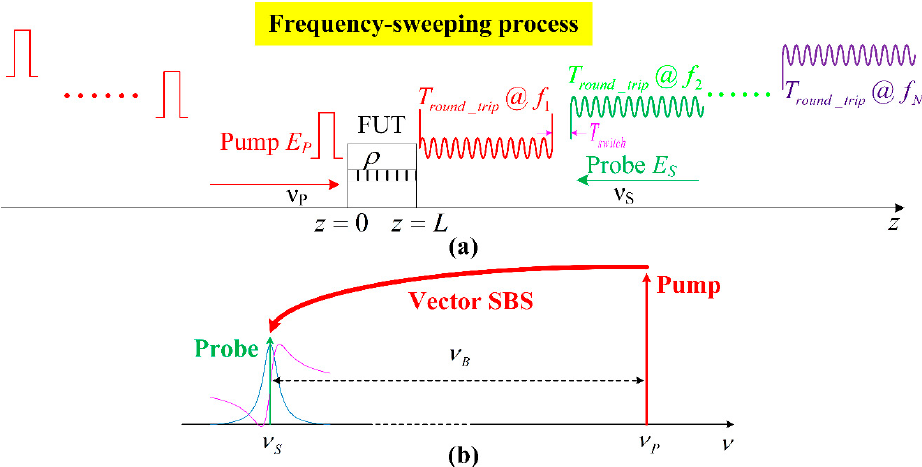
Figure 1. The classical BOTDA scheme. ( a ) The time sequence: the probe wave with the frequency sweeping is switched segment-by-segment as the pump pulses are launched into FUT in the opposite direction maintaining the same time interval T round _ trip + T switch . ( b ) The frequency domain relationship. BGS: blue line. BPSS: magenta line. Pump wave: red line.